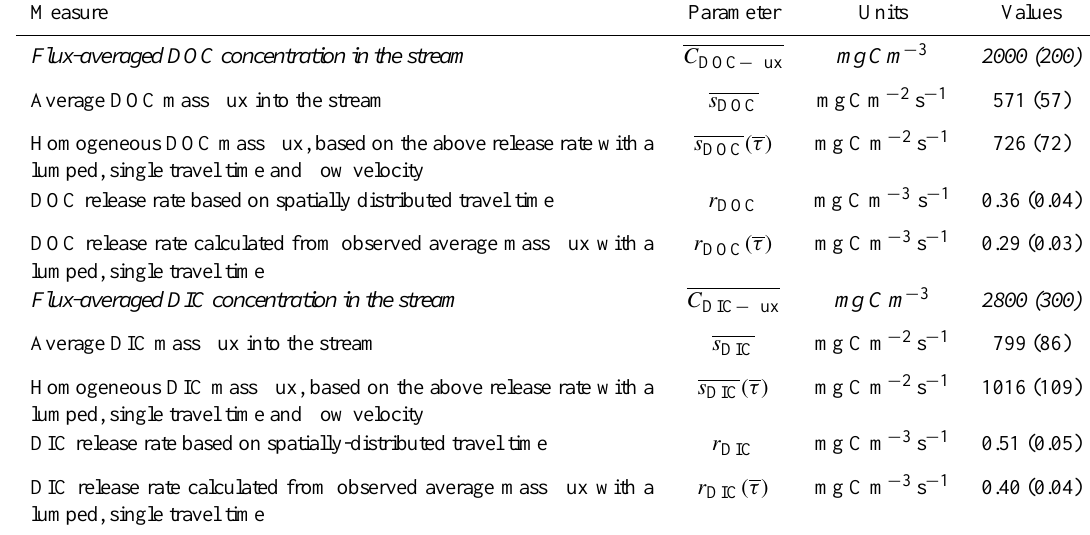
Table 1. Observed concentrations (in italics) and estimated carbon fluxes and release rates for the Abiskojokken catchment. In parenthesis, are standard deviations for observed concentrations and corresponding standard errors (based on one standard deviation) for estimated values.